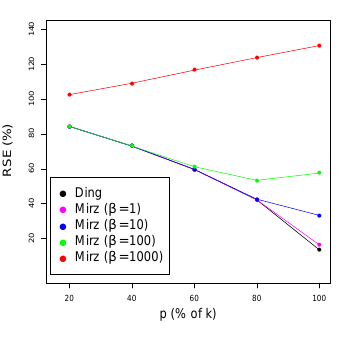
Values of RSE for different values of β obtained by Algorithms 1 and 3 on BION data with n = 500.